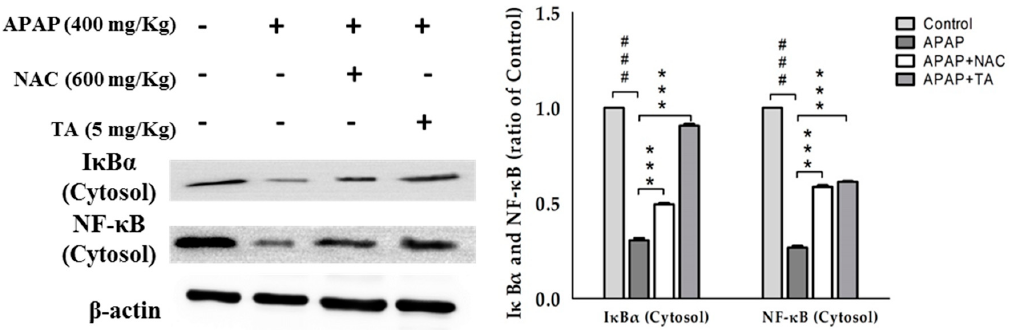
Figure 7. TA inhibited I κ B α and NF- κ B expression in APAP-induced mice. β -actin served as a loading control. The values are reported as the means ± S.E.M. of five mice per group. ### p < 0.01 compared with the control group; *** p < 0.001 compared with the APAP group.